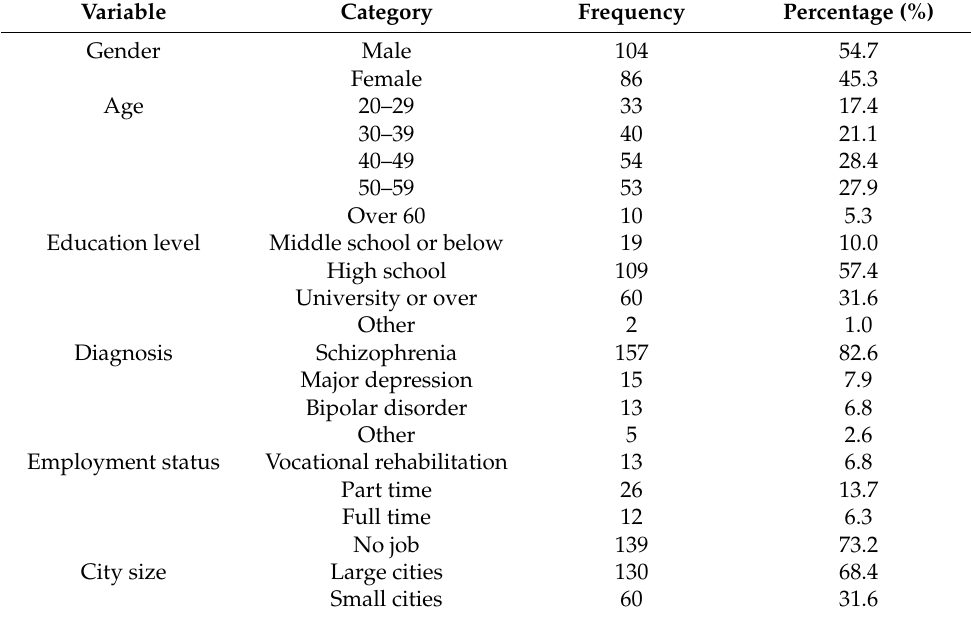
Table 1. Sociodemographic characteristics of the